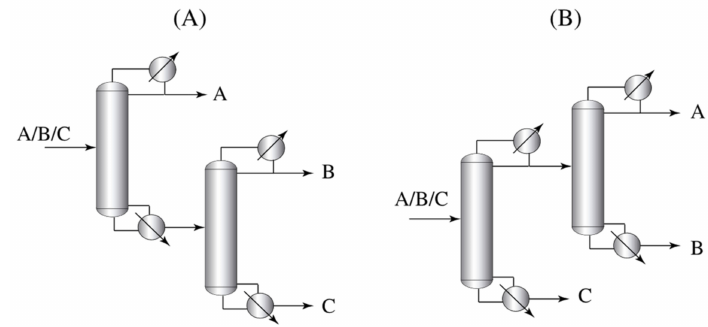
Figure 1. ( A ) Conventional direct and ( B ) indirect distillation sequences. Thermally coupled columns provide an attractive option for the separation of multi- component mixtures. The fully thermally coupled arrangement, also called the Petlyuk column, has been proven to be the most energy-efficient structure for ternary mixtures, and has been implemented in the form of a dividing wall column (DWC) [5]. Figure 2 depicts the Petlyuk arrangement and its implementation as a DWC. Petlyuk or DWC columns have been shown to provide up to 30% energy reduction and 40% lower capital costs compared to traditional distillation arrangements [4]. The principal reason for improved energy efficiency is the reduction or elimination of the remixing effect [6].